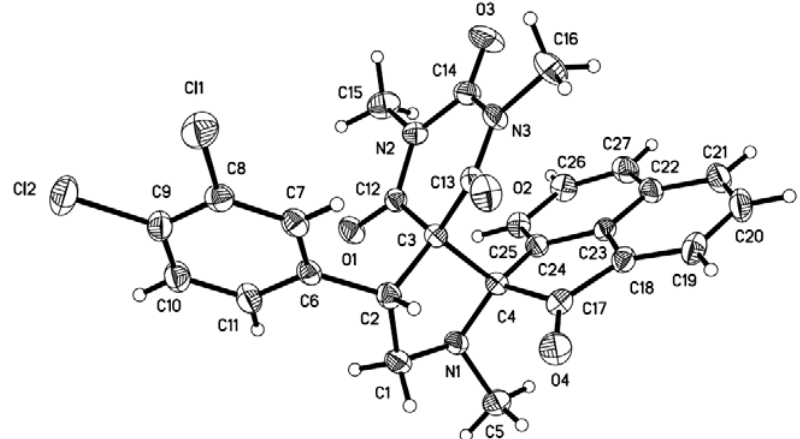
Figure 2. X-Ray crystal structure of compound 8b